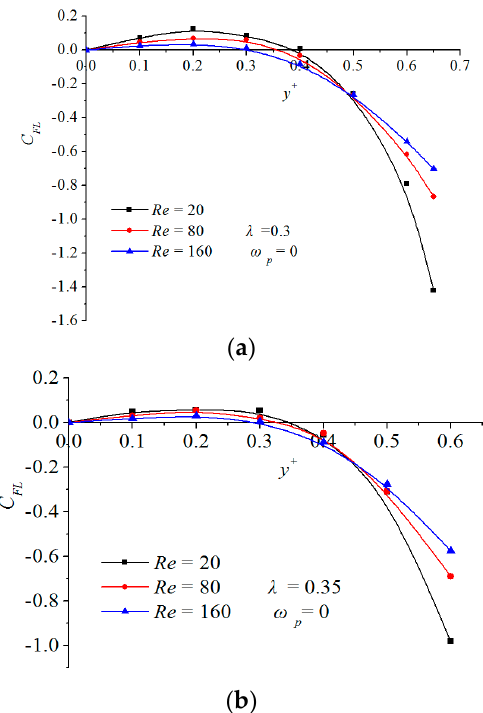
Figure 6. Transverse distributions of the inertial lift force on a migrating particle without rotation at various Reynolds numbers. ( a ) is for λ = 0.3 and ( b ) is for λ = 0.35 at different Re of 20, 80, 160.